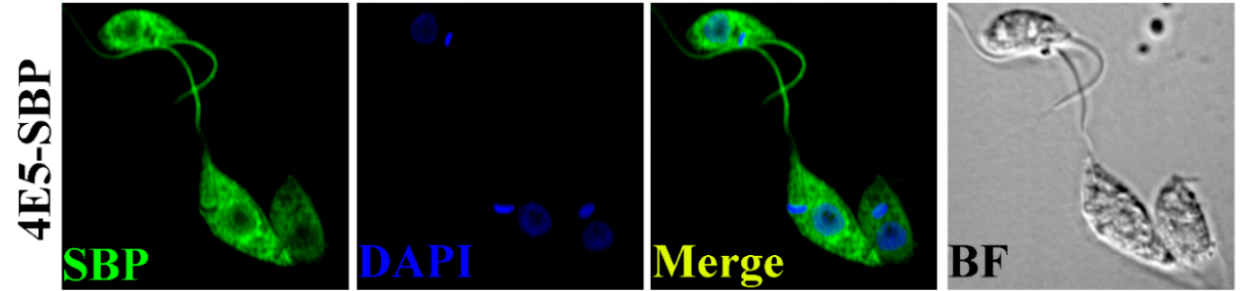
Figure 3. Non-uniform distribution of SBP-tagged LeishIF4E-5 in the cytoplasm and in foci surrounding the nucleus. Transgenic L. amazonensis promastigotes expressing SBP-tagged LeishIF4E-5 were fixed, permeabilized and processed for confocal microscopy. LeishIF4E-5-SBP was detected using a monoclonal antibody against the SBP tag and a secondary DyLight-labeled antibody (488 nm; green). Nuclear and kinetoplast DNA was stained using DAPI (blue). A bright field (BF) picture of the cells is on the right. The confocal analysis was repeated three times. A broad view of the field is given in Figure S4.